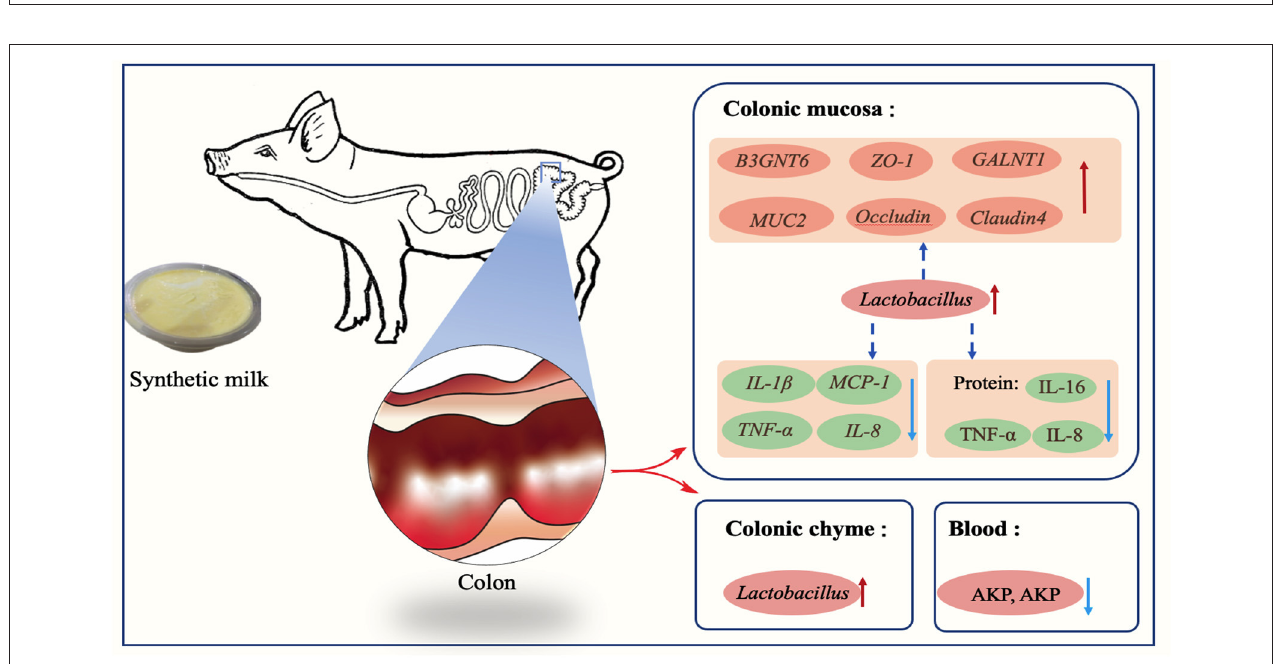
FIGURE 10 | Early-life nutrition interventions improved growth performance and intestinal health via the gut microbiota in piglets: a possible mechanism.